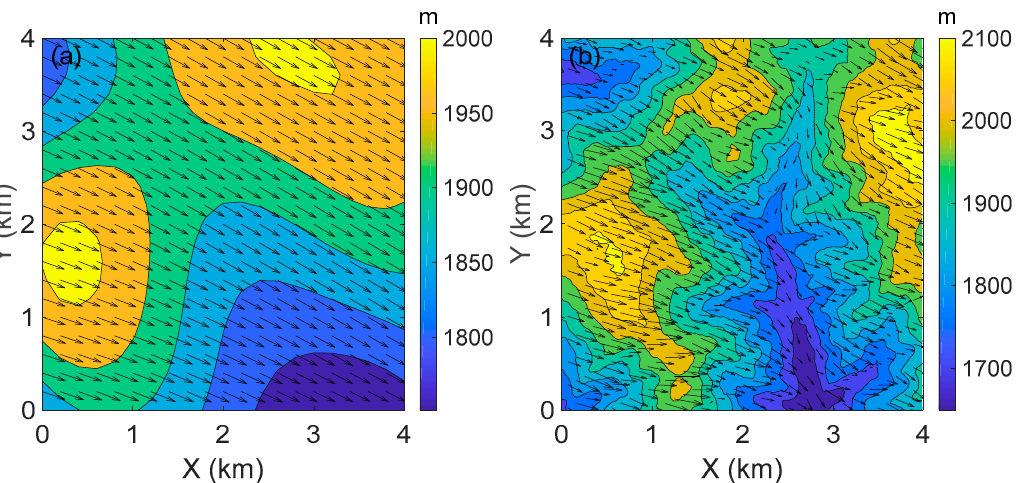
Figure 9. The topography (m) and simulated wind (vectors) at a height of 10 m: ( a ) WRF simulation; ( b ) CFD simulation.